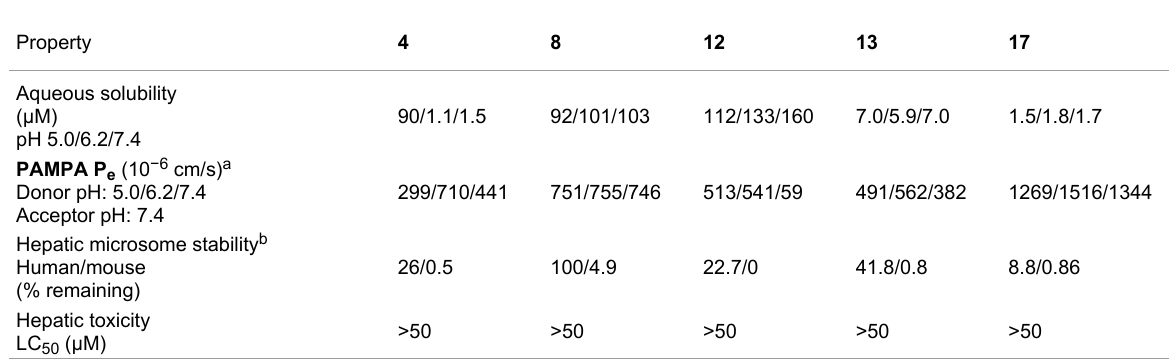
Table 2: Summary of in vitro ADME/T properties of probes.